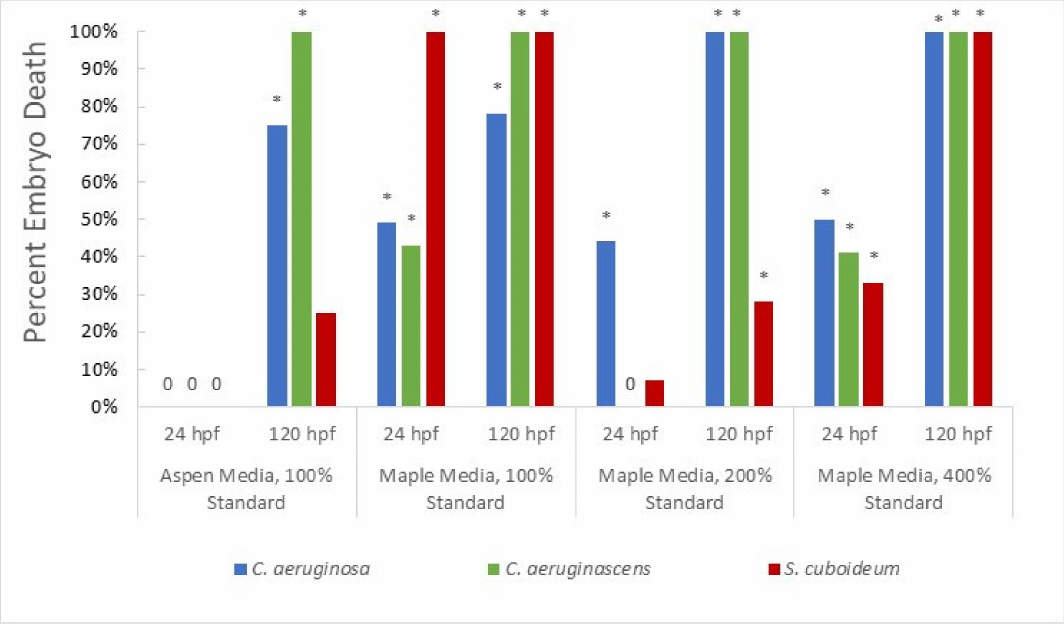
Figure 2. Percent Embryo Death After Exposure to Dichloromethane Extracted Pigments from Fungi at 24 and 120 hpf. Asterisks denote significant difference from control, with all significant values having a p -value of <0.0001 as determined by Fisher’s exact test. Zeros indicate there was no fish mortality in that condition. DCM-extracted pigment is shown to result in significantly more mortality than control across a number of test conditions, with higher embryo death rates after longer exposure. Aspen media resulted in less mortality than maple media, and higher concentrations of maple media resulted in more deaths for pigments from most fungal